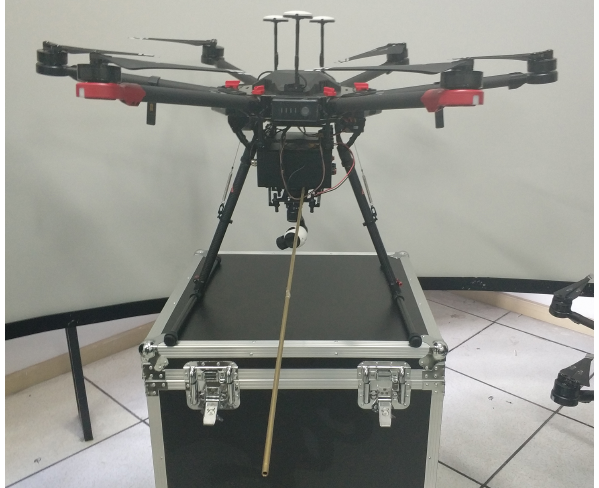
Figure 2. UAV platform flying close to the smoke stack for collect- ing exhaust gas in the automatic engine room laboratory of Shang- hai Maritime